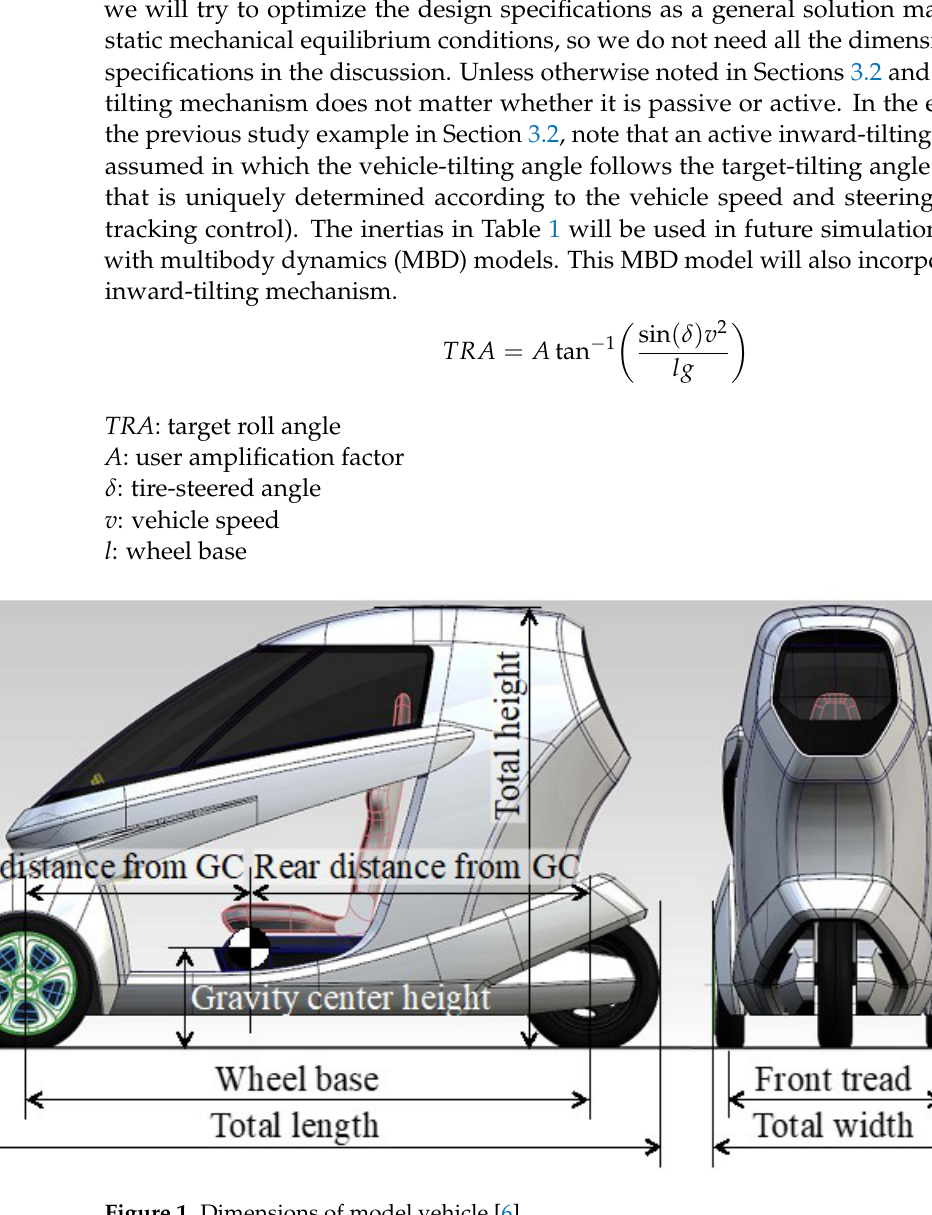
Figure 1. Dimensions of model vehicle [6]. Table 1. Specifications of model vehicle